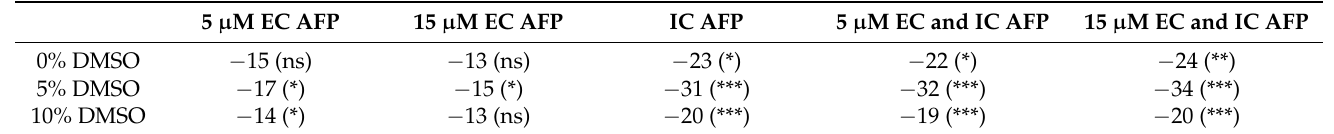
All experiments contained 3 biological repeats ( n = 3), with each containing 3 technical repeats. n.s. p > 0.05, * p ≤ 0.05, ** p ≤ 0.01, *** p ≤ 0.001.